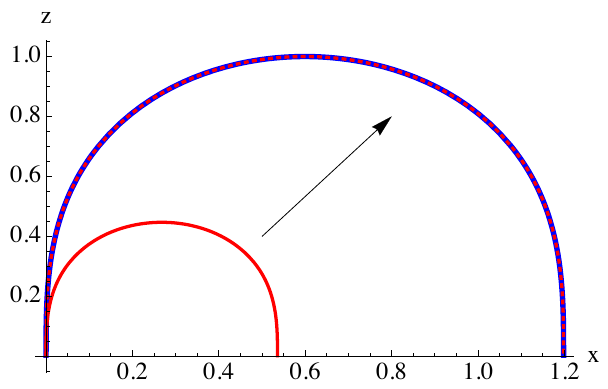
Figure 5 . The small red curve is z 1 ( x ) with w 1 = 0 : 536, and the large blue curve is z 2 ( x ) with w 2 = 1 : 20. The red dotted curve is w 2